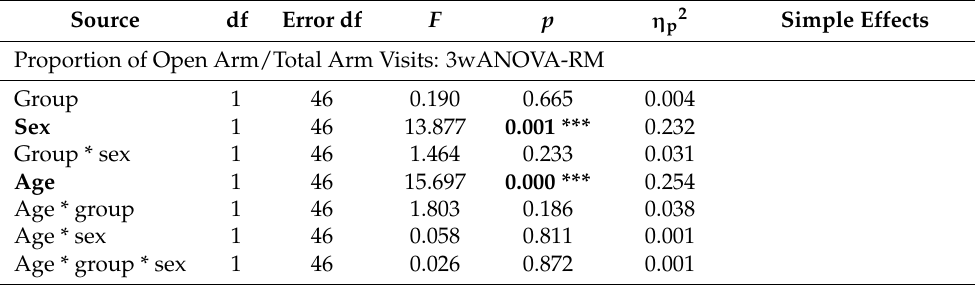
Table A8. Three-way ANOVA-RM and two-way ANOVA table for the elevated plus maze test. Source η p2 Simple